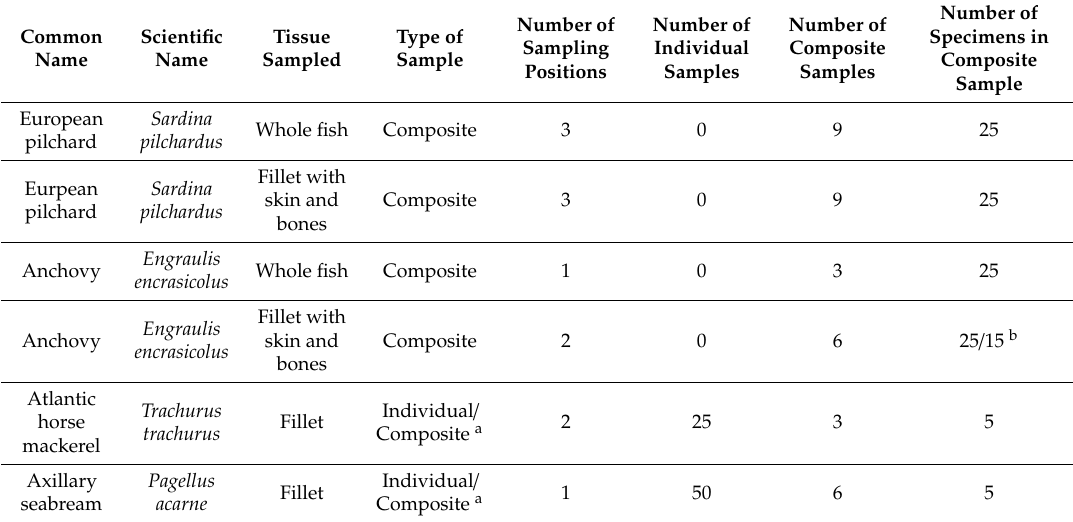
Table 1. Overview of species sampled, type of sample, and number of fish in each sample from Northwestern African marine ecosystems, May